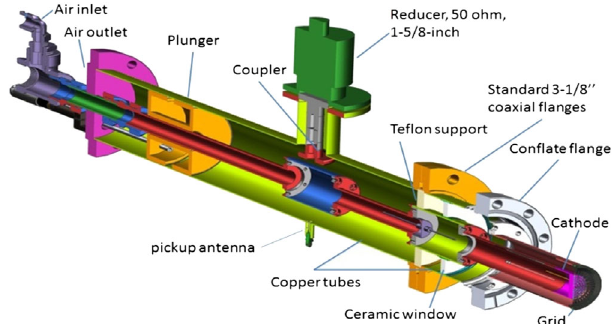
FIG. 2. The rf gun design parameters (left) and components